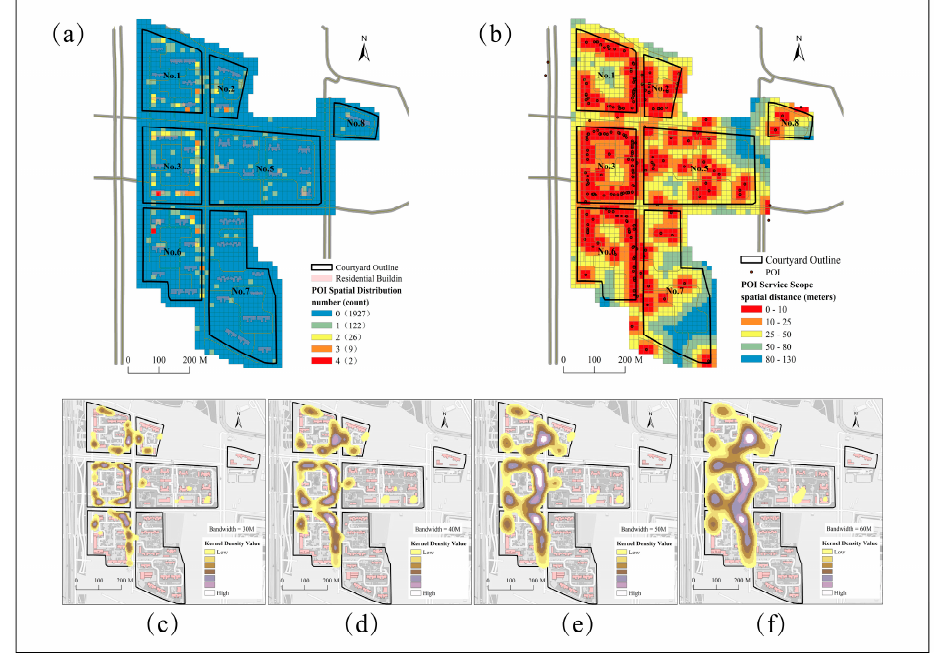
Figure 5. The POI spatial analysis results. ( a , b ) represent the spatial distribution and spatial service of POIs, (c,d, e , f ) denote the POI kernel density estimation results for various bandwidths.